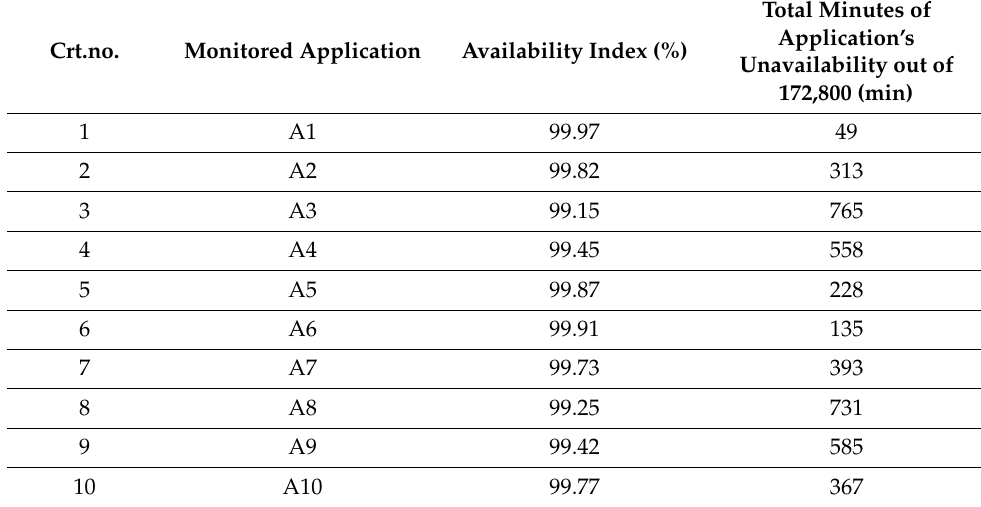
Table 3. Analysis of availability as shown by intelligent agent Davis AI.